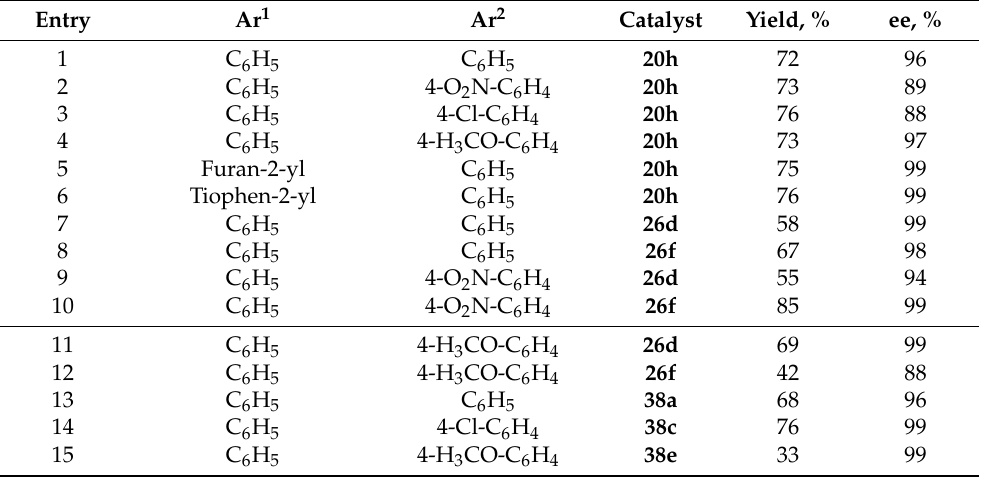
Table 5. Effect of crown ethers in the Michael addition of chalcones ( 49 ) and diethyl acetoxymalo- nate ( 61 ).